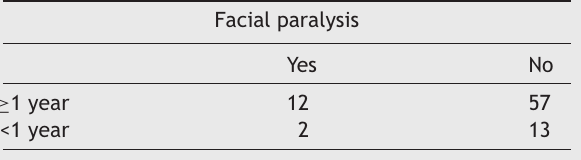
Case-control table --- duration of the disease (1 year).